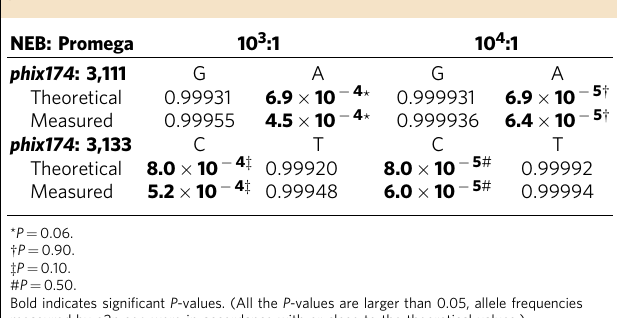
Figure 4 | Performance of o2n-seq for detecting mutations with 1% and 0.1% allele frequency. ( a , b ) Sensitivity and FPR of mutation detection of o2n-seq (three experimental replicates, orange), Cir-seq (three experimental replicates, blue) and o2n-seq after filtering with frequency (o2n-seq-f, green) under different CSs criteria for the 1:100 mixture of E. coli (means ± s.d.). Two-tailed Student’s t -test was used for statistical analysis. ( c ) Mutation frequency distribution of FP and TP variants detected by o2n-seq under different CSs (1 (cid:3) and 2 (cid:3) ) for the 1:100 mixture of E. coli . 3 (cid:3) -5 (cid:3) CSs were showed in Supplementary Fig. 5. ( d ) MAFs of TP mutations detected by o2n-seq for the 1:100 mixture of E. coli . The MAFs of three experimental replicates was plotted. The dashed horizontal line indicates the theoretical MAF (0.99%). ( e , f ) Sensitivity and FPR of mutation detection of o2n-seq by different CSs criteria (3 (cid:3) (cid:2) 9 (cid:3) ) under different total CSs coverage (5,000–25,000 (cid:3) ) for the 1:1,000 mix of phix174 . The results of the other experimental replicate were shown in Supplementary Fig. 6. Dash lines were used to display the overlapped results better. Table 1 | Allele frequencies of two phix174 strains Table 2 | Theoretical and measured allele frequencies of (NEB catalog N3021S and Promega catalog D1531). phix174 mixtures at different